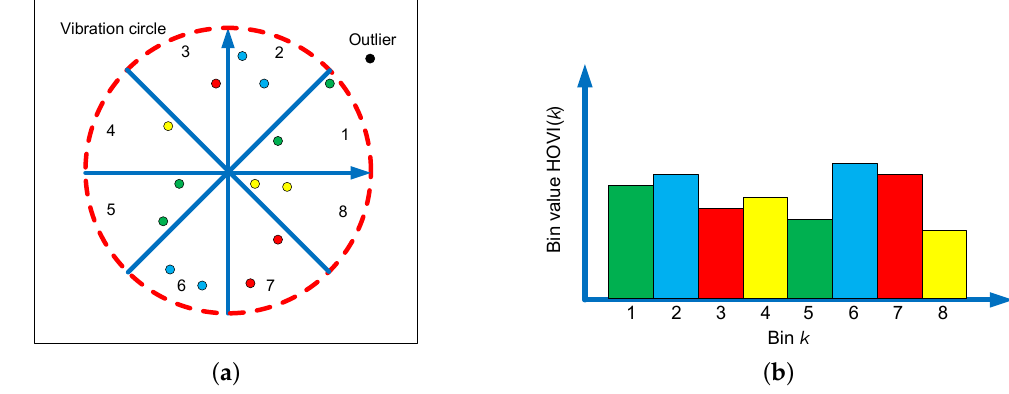
Figure 6. The schematic of HOVI: ( a ) distribution of vibration points in various directions; and ( b ) histogram of oriented vibration